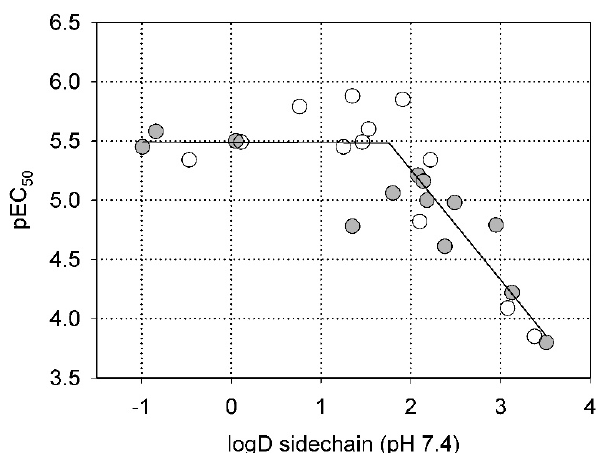
Figure 2. Dependence of the inhibitory activity of the compounds in Table 2 (as pEC 50 ) on the polarity of the substituent at the 2-amino group of thiazole (expressed as partition coefficient, logD, at pH 7.4). Open circles—amides; filled